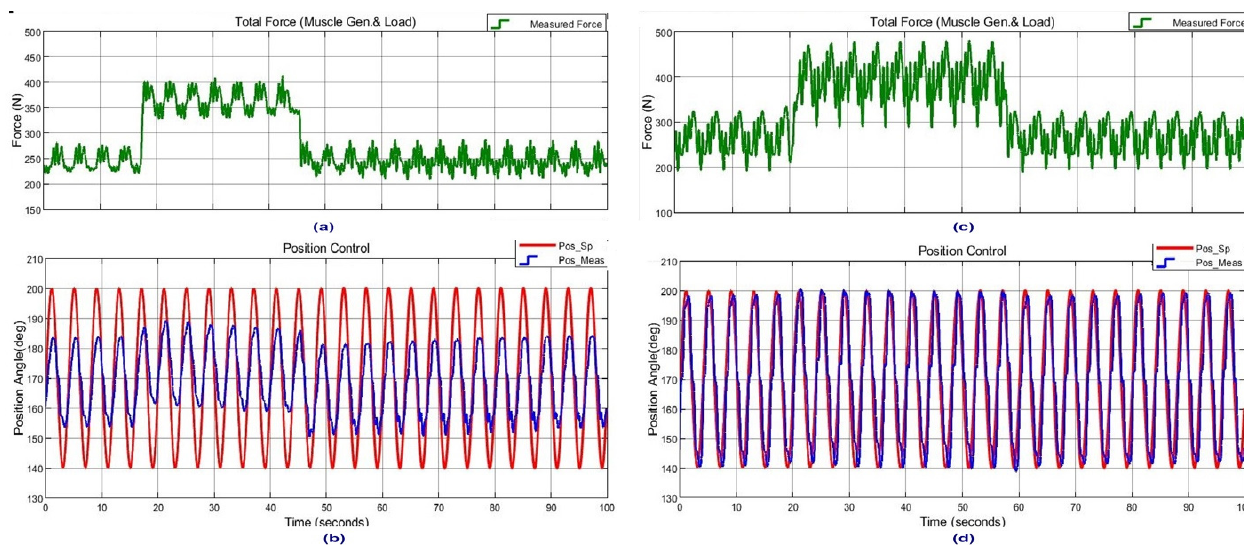
Figure 23. Dynamic external load addition and removal performance comparison results for 0.25 Hz sinusoidal reference position tracking: ( a , b ) PID-only operation and ( c , d ) NARX active operation responses.